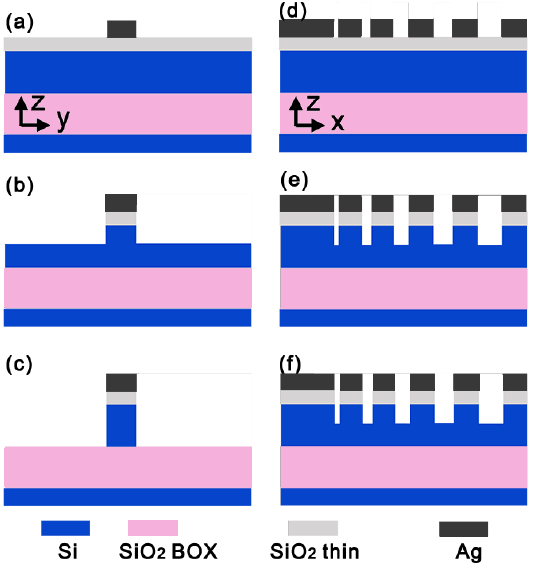
Figure 5. Fabrication processes for the silicon HPWs with a metal cap. The left column depicts the y-z cross-section views of the waveguide while the right column presents the x-z cross-section views of the grating coupler. ( a , d ) After Ag patterns are defined. ( b , e ) After Si is partially etched to form the grating grooves. ( c , f ) After the exposed Si slab is etched through, during which the Si slab in the grating grooves is protected.